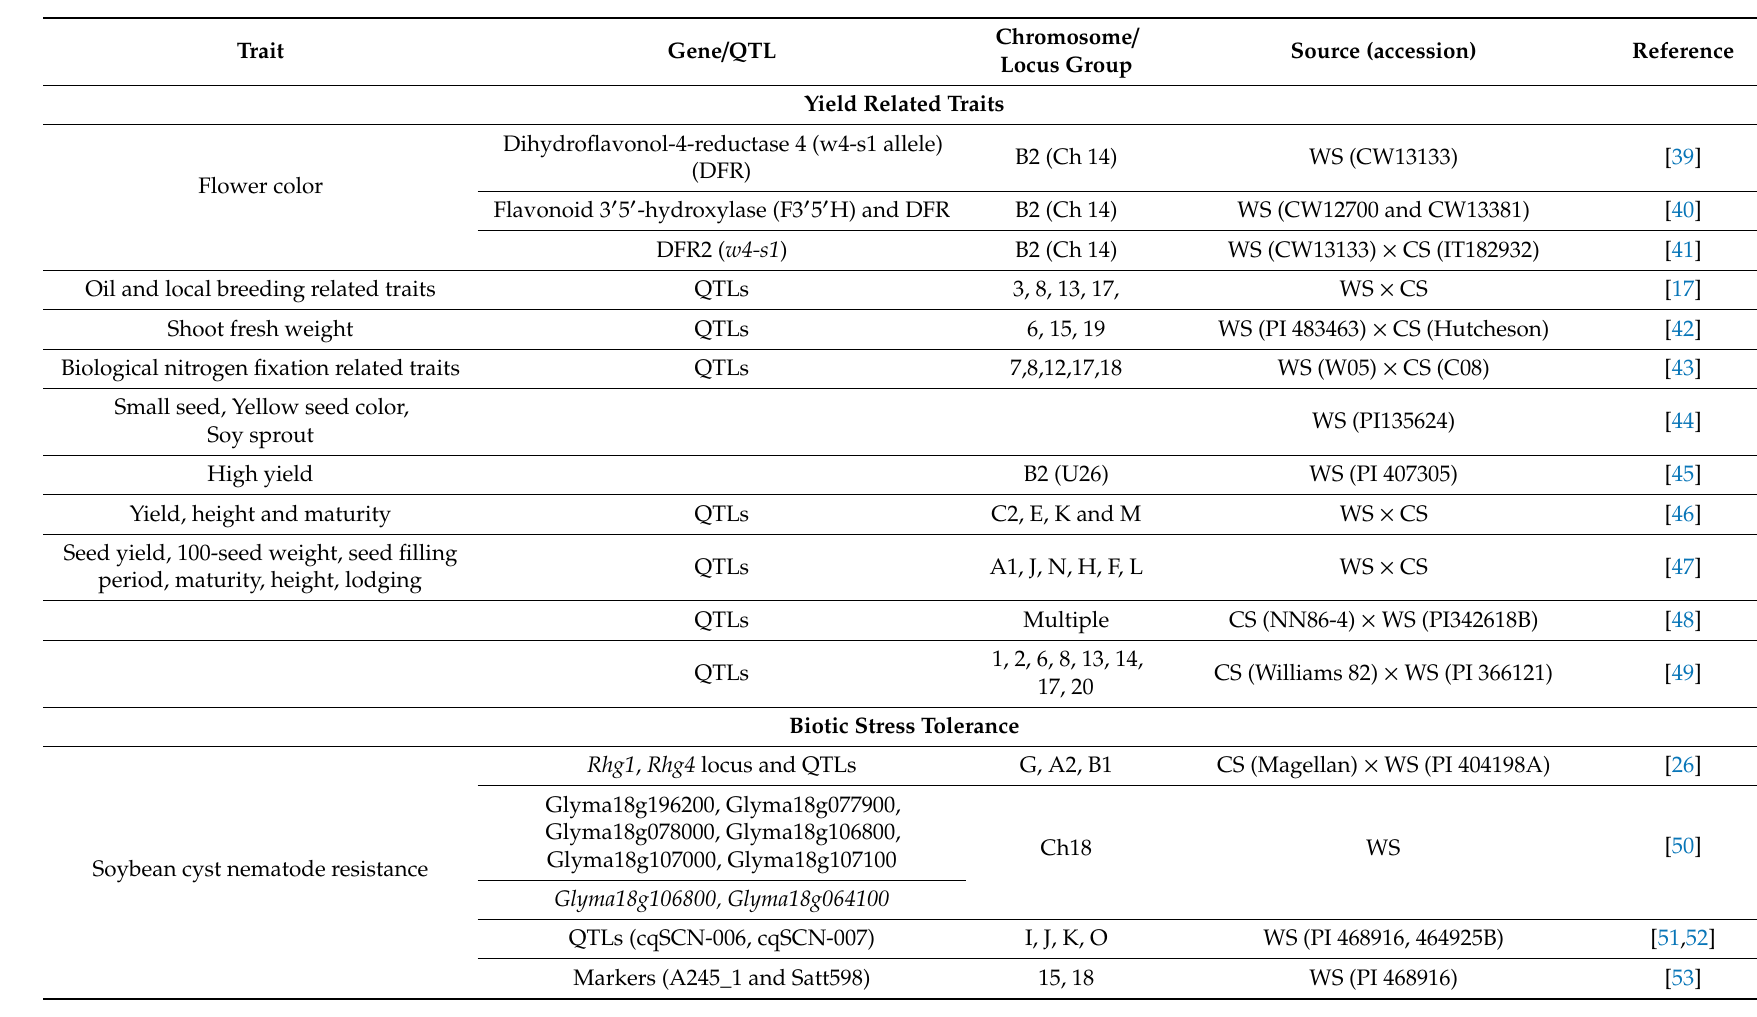
Table 1. List of genes and QTLs found to be associated with specific traits using either wild soybean or a cross between wild and cultivated